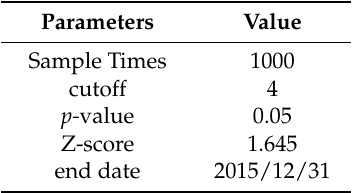
Table 1. The parameters for